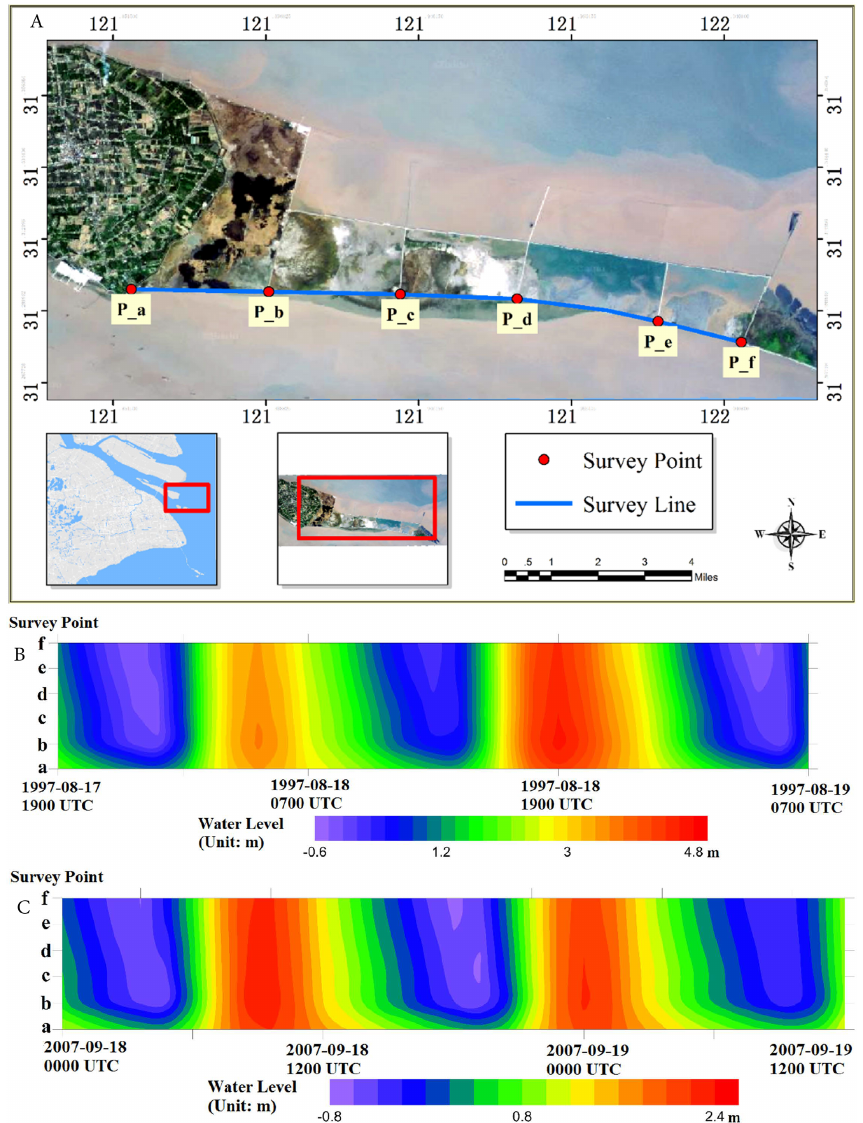
Figure 9. (a) Location of the survey line (blue) and six survey points (red) along the south bank of the reclamation project around Hengsha Island, as well as distribution of water level (m) at the survey points during (b) Winnie and (c) Wipha. Sources: Esri, DigitalGlobe, GeoEye, i-cubed, USDA FSA, USGS, AEX, GetMapping, AeroGRID, IGN, IGP, swisstopo and the GIS user